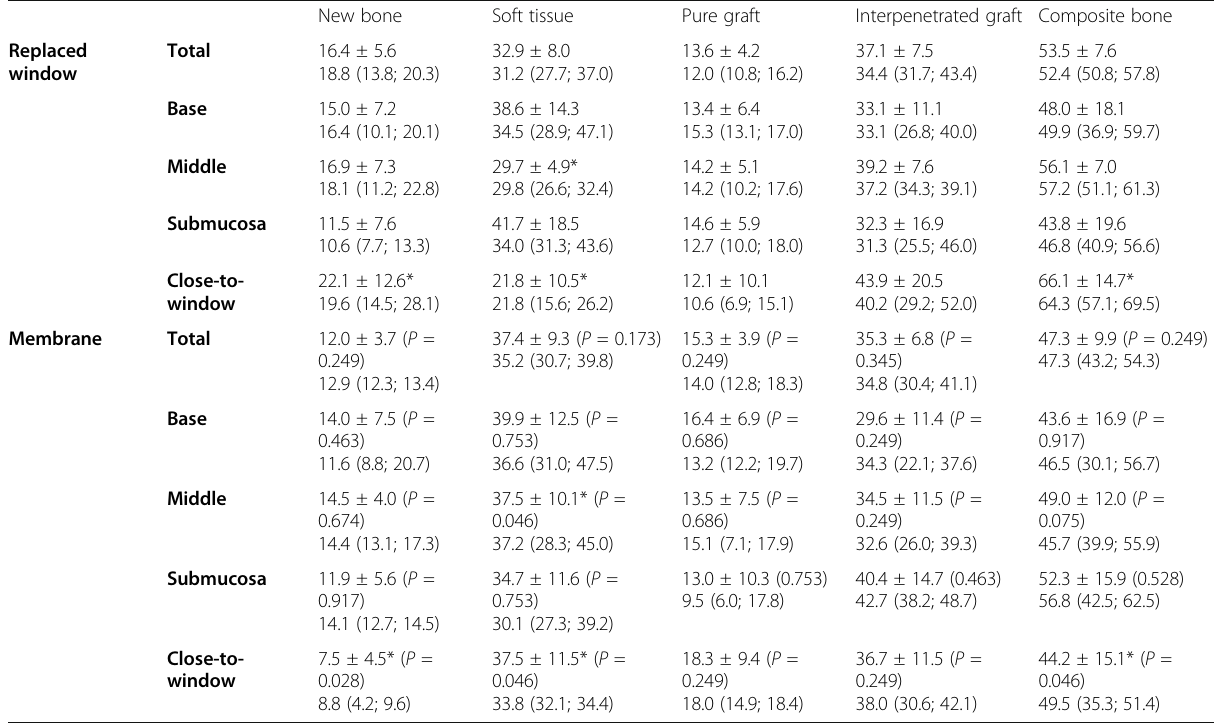
Table 1 Percentages of the various tissues within the elevated area after 4 months of healing. Mean values ± standard deviations ( P values) and median (25%; 75% percentiles) New bone Soft tissue Pure graft Interpenetrated graft Composite